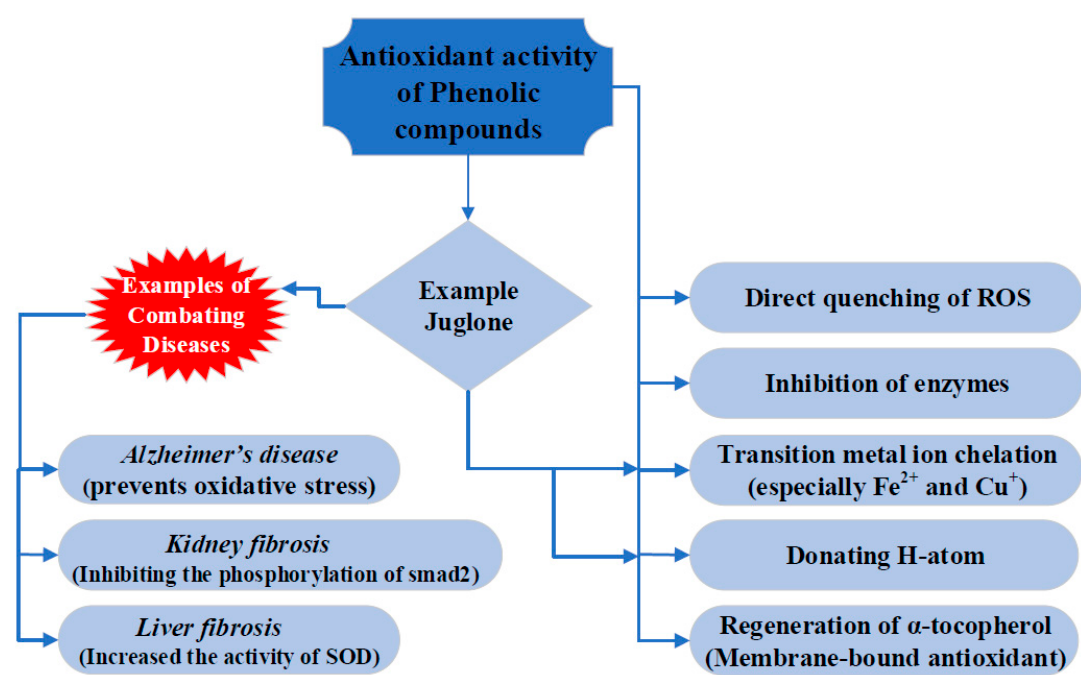
Figure 2. Schematic diagram describing the antioxidant properties of phenolic compounds including